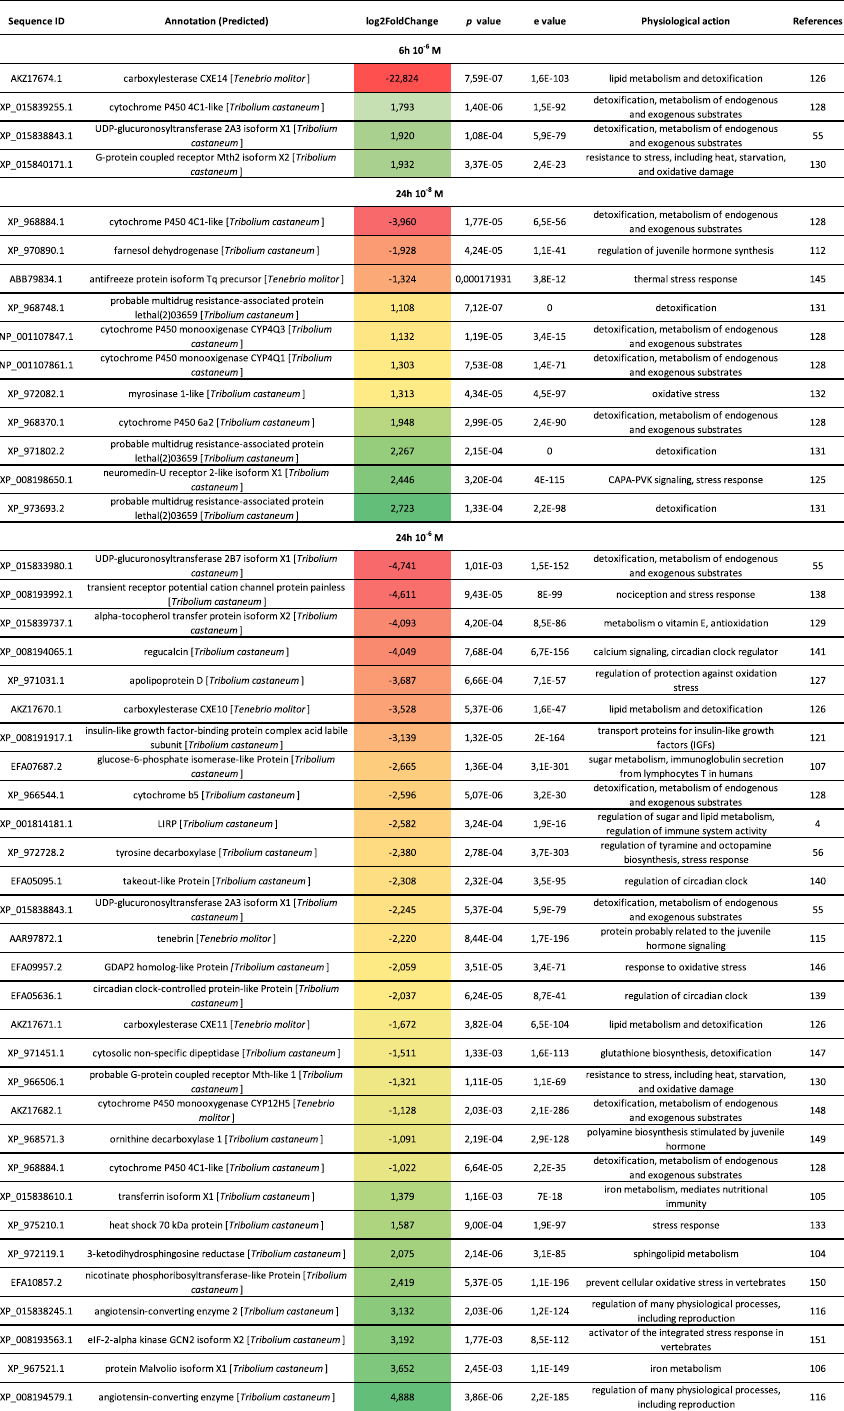
Table 3. Statistically significant differences in the expression levels of selected metabolic- and stress-related genes in the immune-related tissue of T. molitor collected 6 and 24 h after Tenmo-TRP-7 treatment at concentrations of 10 –8 and 10 –6 M. Gradient from red to green: Fold change values represent the increased (green) or decreased (red) abundance of transcripts (adjusted p value of < 0.05) compared to the control individuals injected with physiological